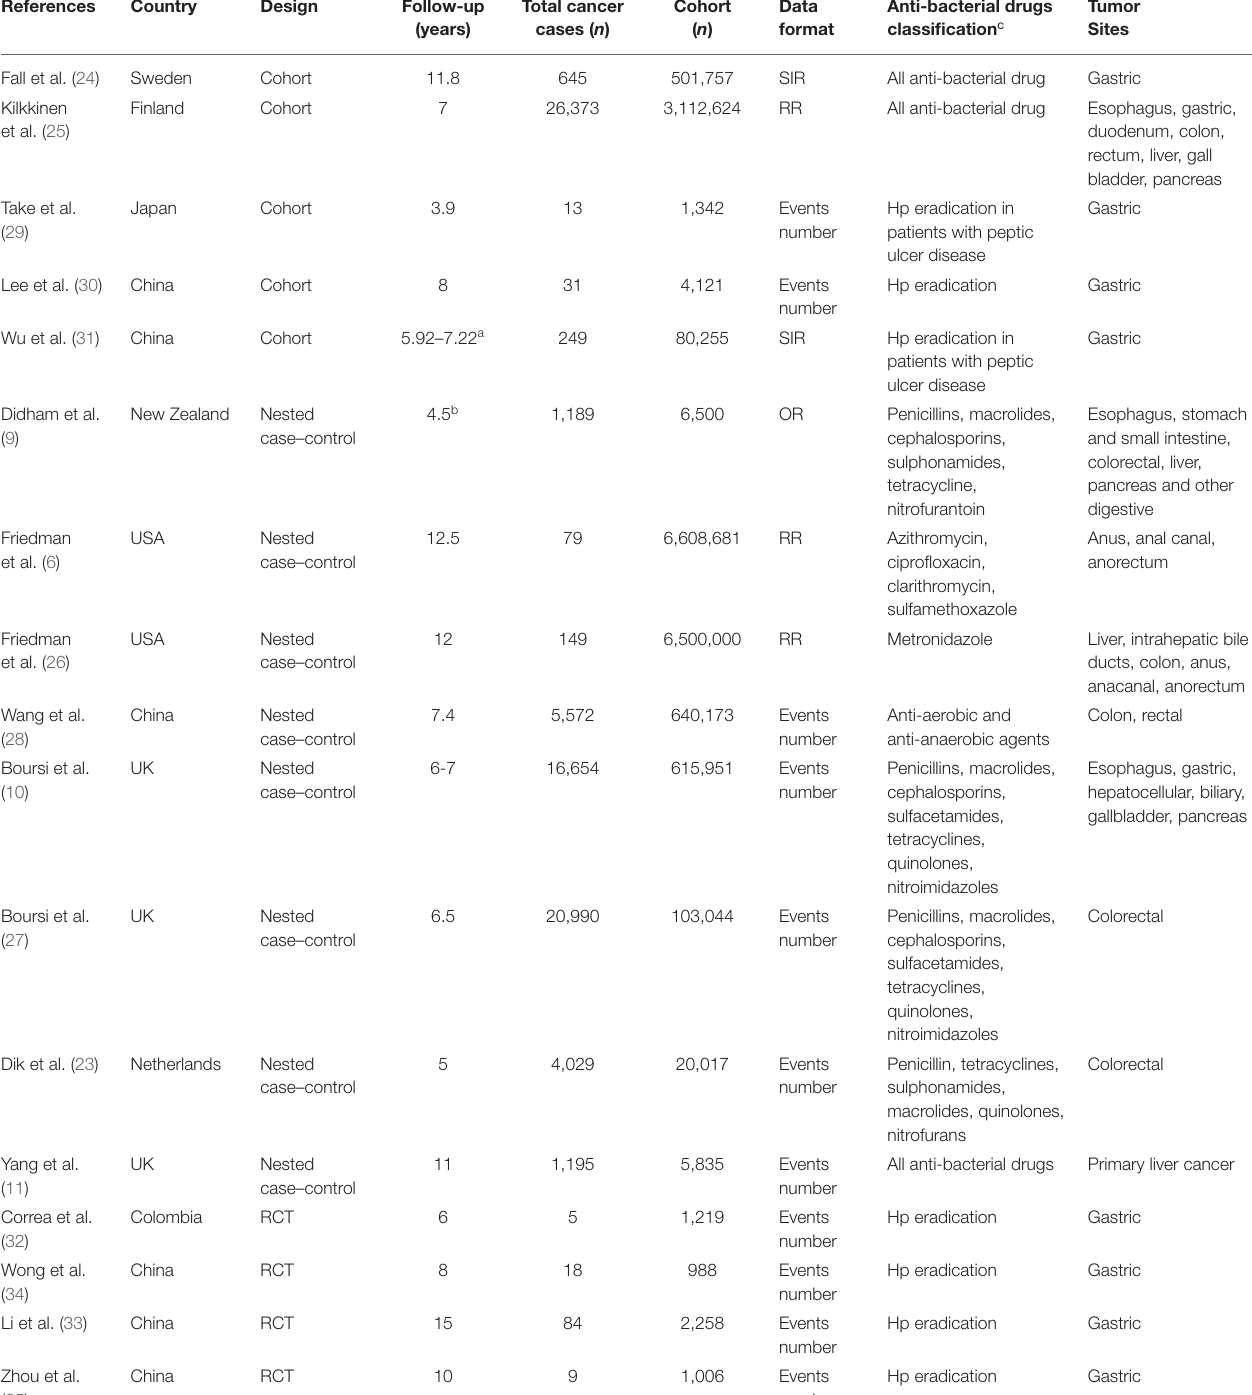
TABLE 1 | Summary of included study